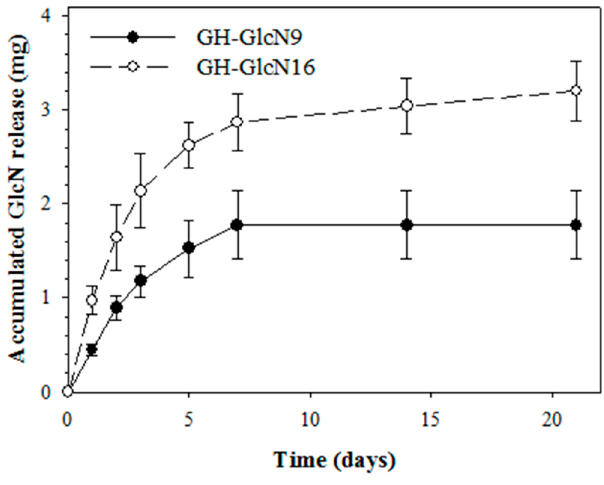
Figure 3. Glucosamine (GlcN) release from GH, GH-GlcN9 and GH-GlcN16 cryogels.